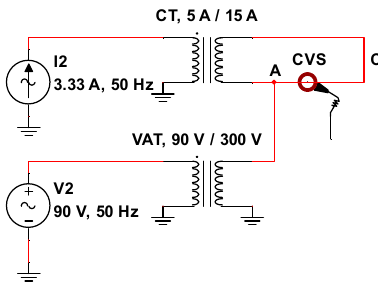
Figure11. Virtualloadconnection, bymeansofacurrenttransformer(CT)andavoltageautotransformer Figure 11. Virtual load connection, by means of a current transformer (CT) and a voltage (VAT) for the characterization of the CVS. autotransformer (VAT) for the characterization of the CVS.